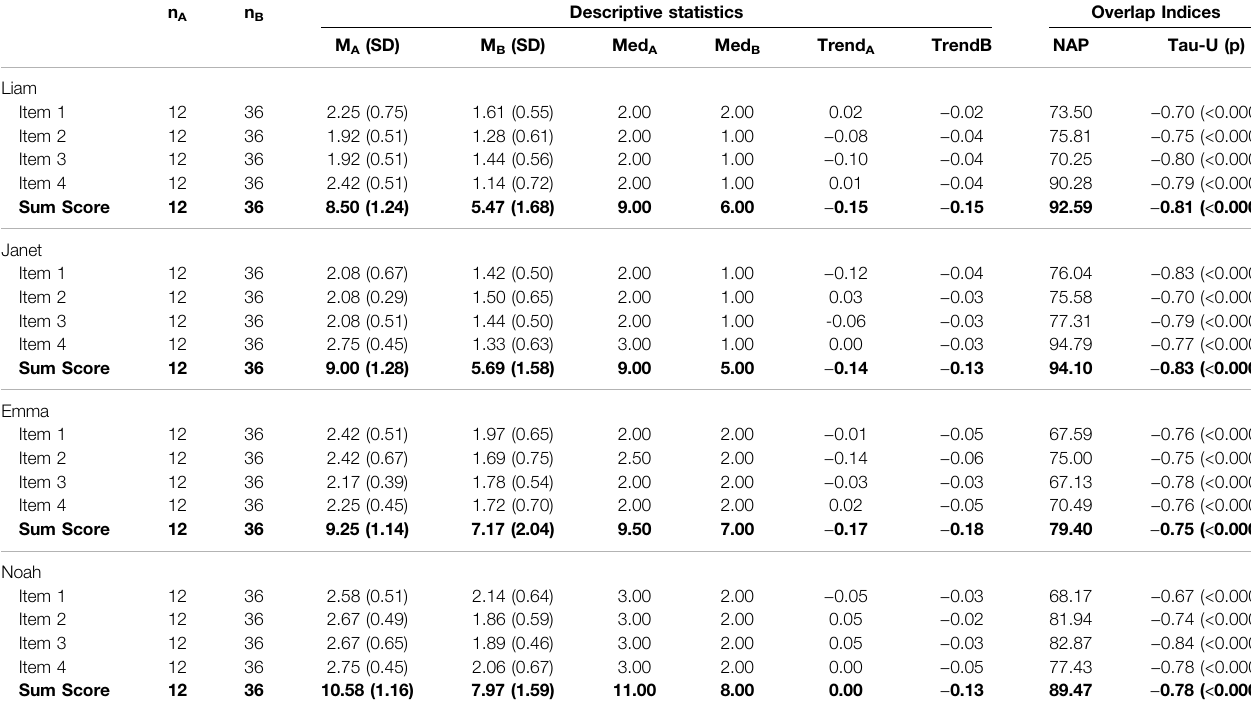
TABLE 1 | Descriptive Statistics and Overlap Indices for the Single Behavior Scores and the DBR-MIS Sum Scores for each Student. n A n B Descriptive